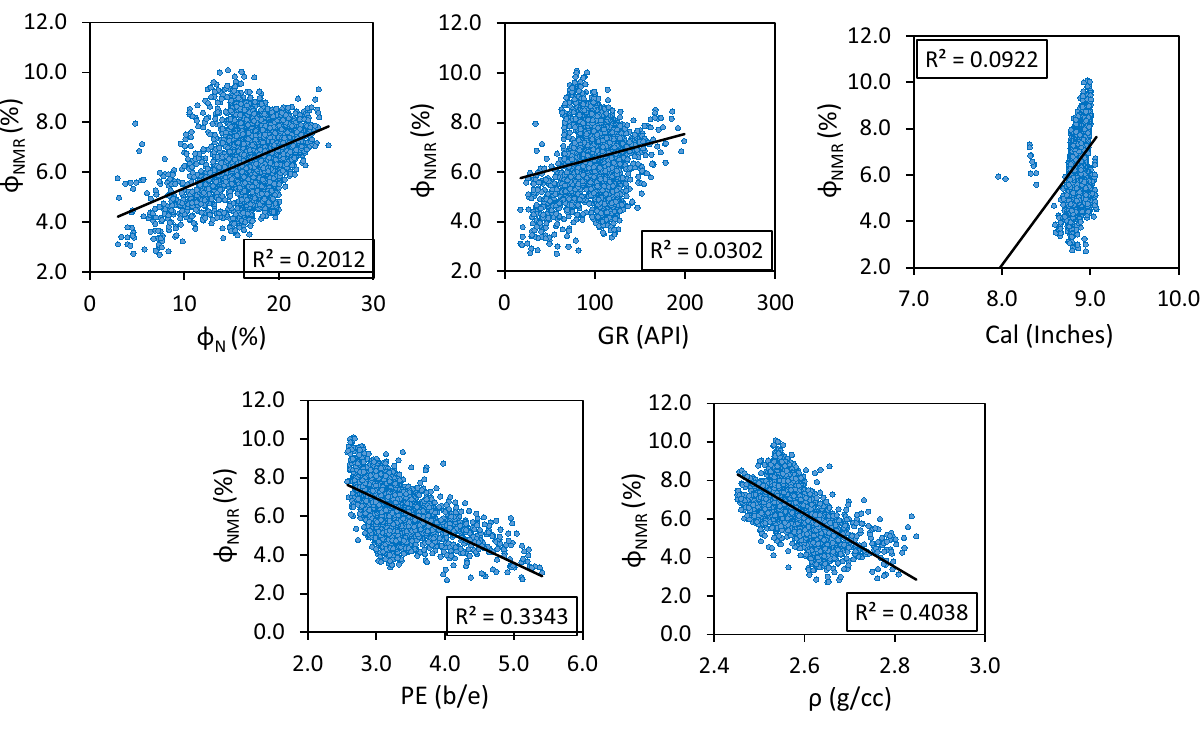
Figure 5. Cross plots of input parameters with Φ NMR .